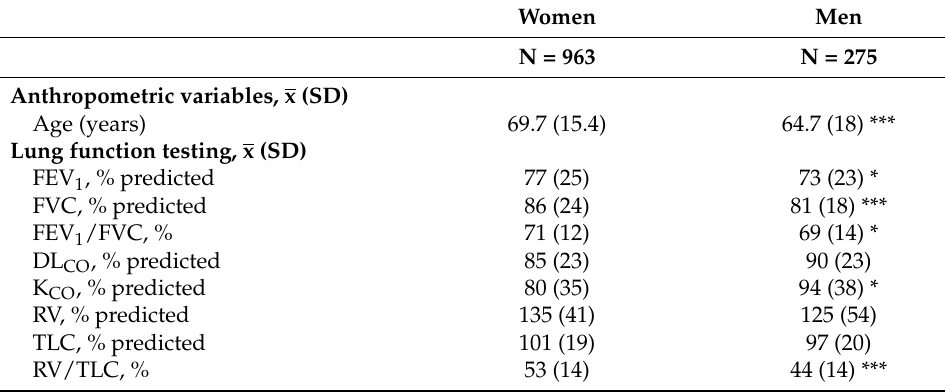
Table 3. Lung function in never-smoker patients: females and males.